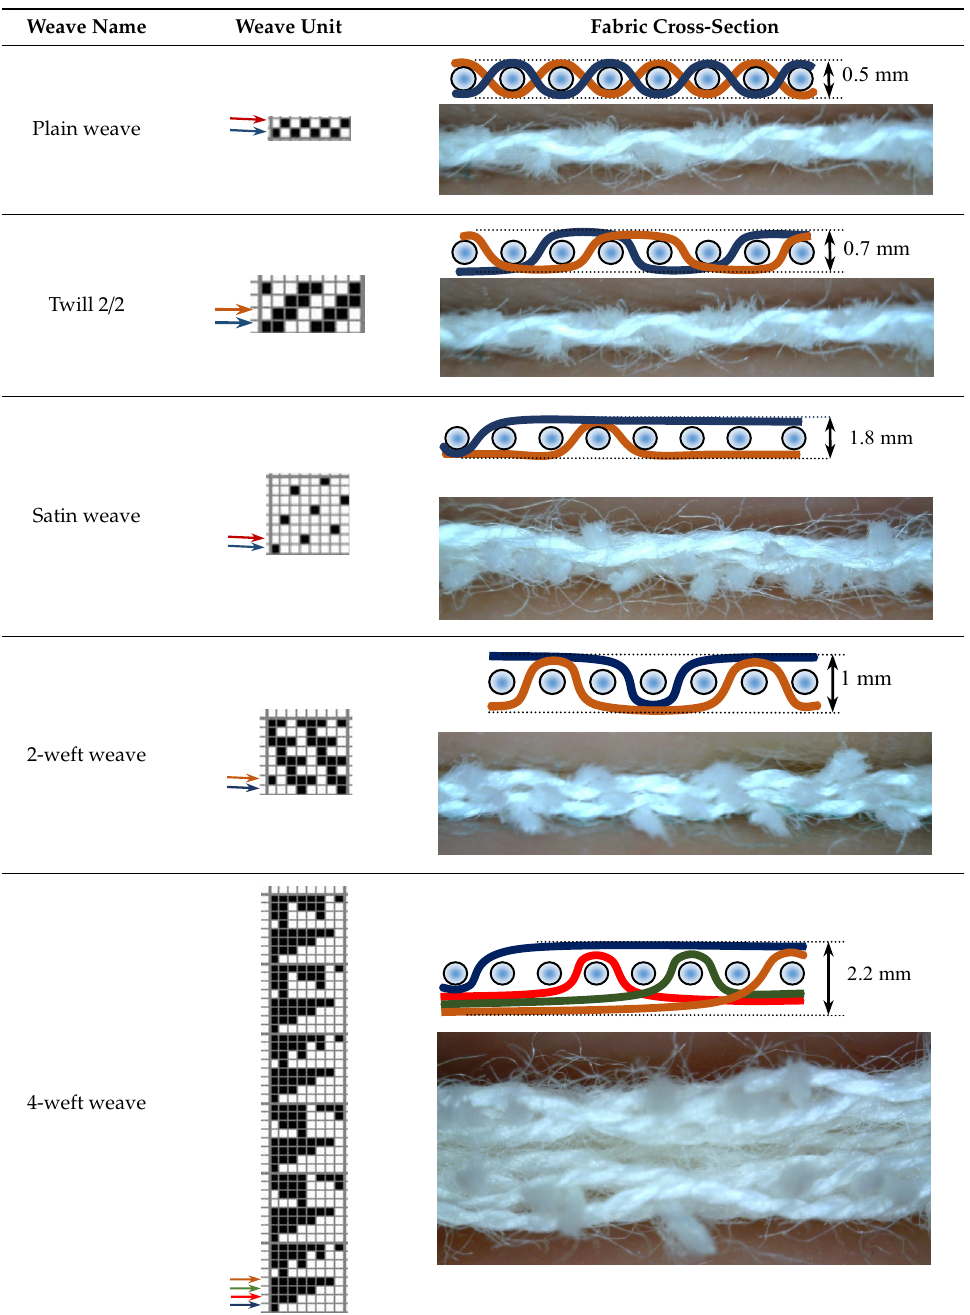
Table 2. Structures and cross-sections of fabric samples; weave name, weave unit, thread cross-section.